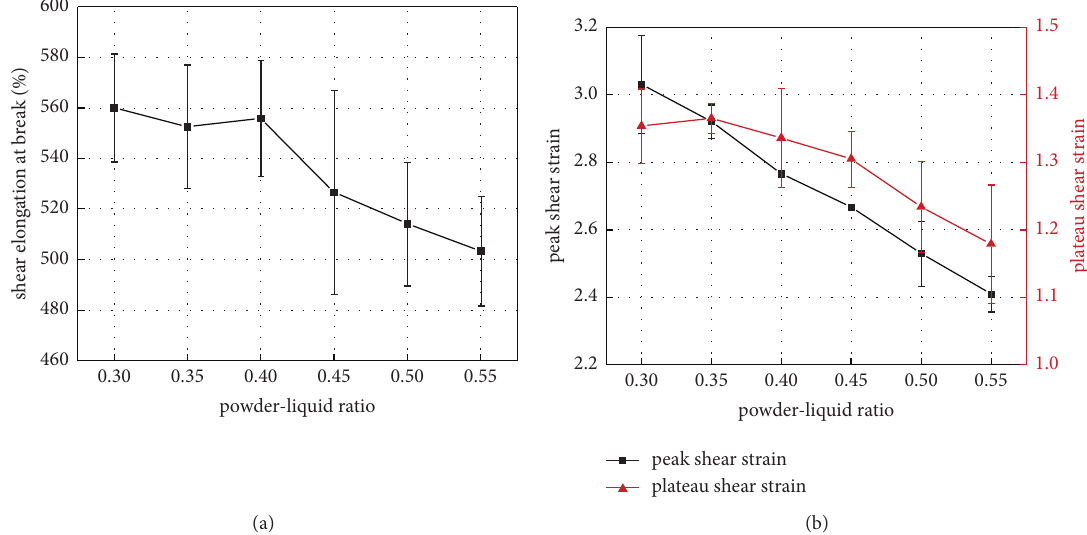
Figure 14: Changes of PCC shear deformation indexes with powder-liquid ratio: (a) shear elongation at break; (b) peak shear strain and plateau shear